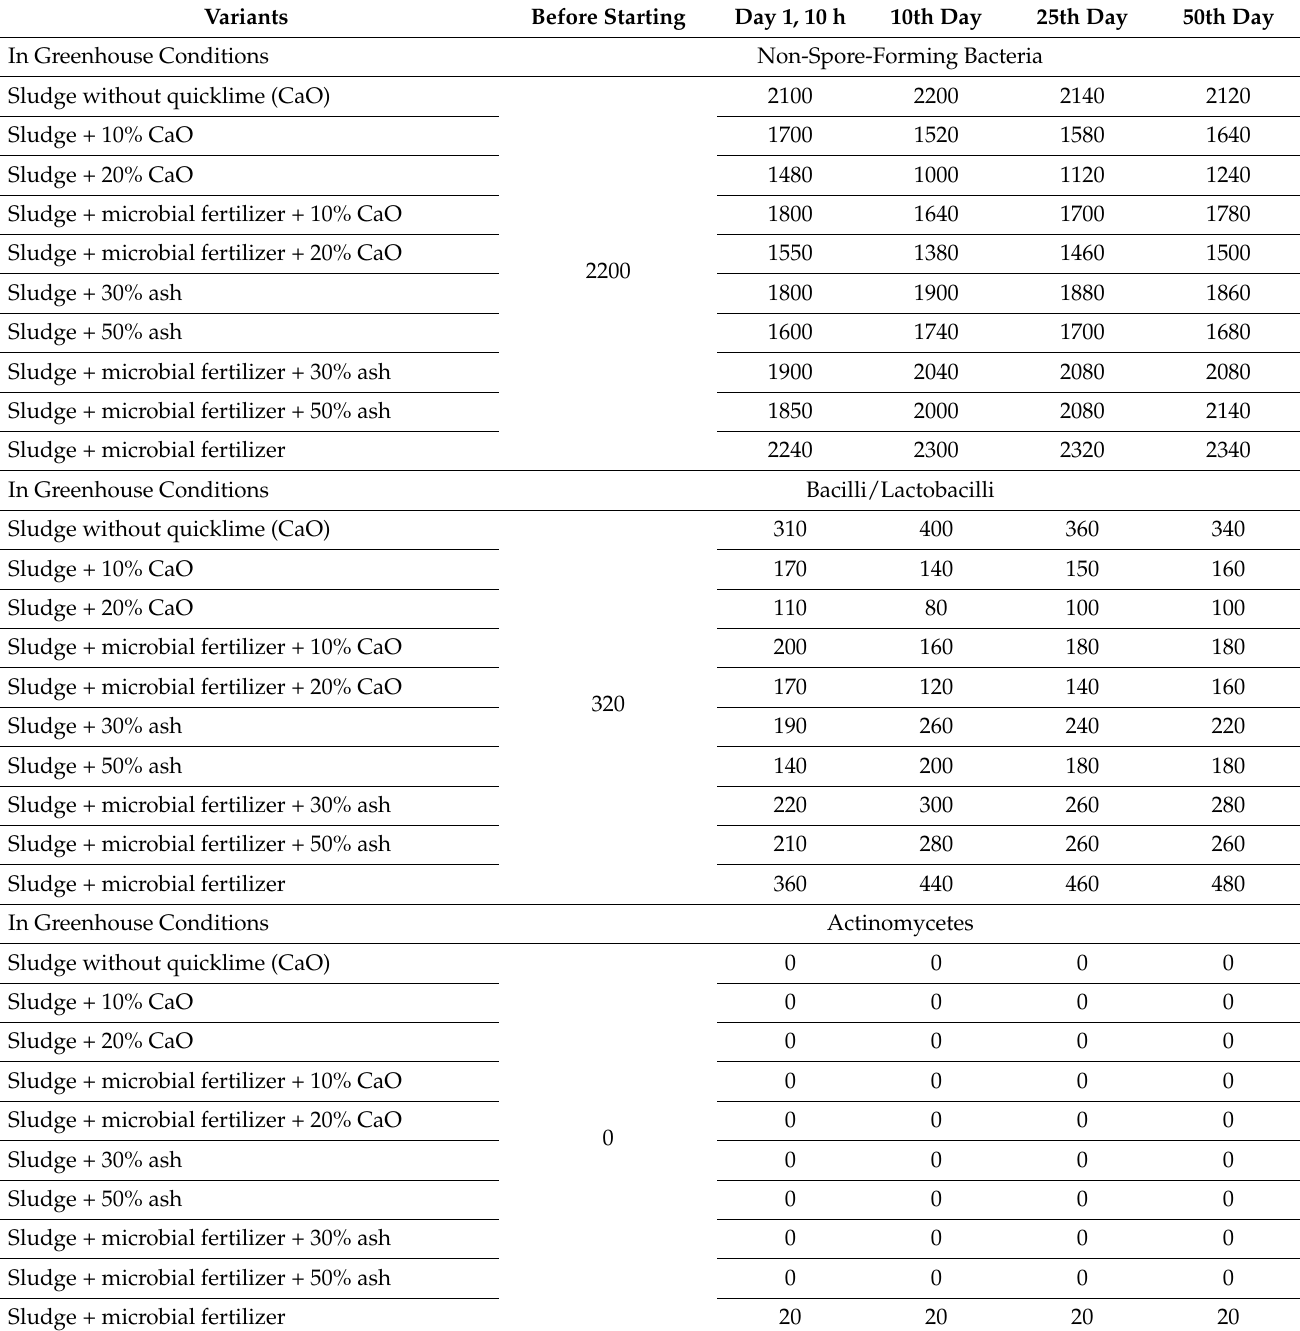
Table 2. Quantity and qualitative composition of non-pathogenic microflora in raw sludge (cfu/g) in